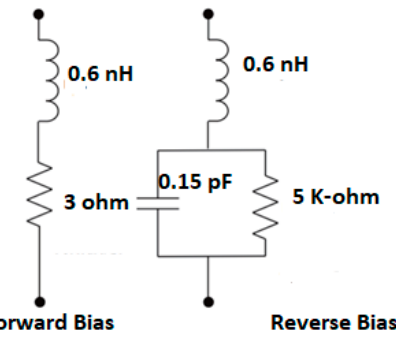
Figure 7. Equivalent circuit of p-i-n diode in ON–OFF condition. The antenna displays various frequency bands with the switching of the diodes. The simulated and measured outcomes provide good agreement, as presented in Figure 8. With both diodes in the ON condition, the antenna illustrates a resonance at 5.1 GHz, with an S 11 of − 24 dB from 2.7 to 5.9 GHz with a bandwidth of 3200 MHz, as shown in Figure 8a. Switching Diode-D1 OFF and Diode-D2 ON provides three bands, defined in Figure 8b, from 1.4 to 1.5 GHz, 2.7 to 4.2 GHz, and 4.6 to 5.9 GHz. With Diode-D1 turned ON and Diode-D2 turned OFF, there are three bands from 1.4 to 1.5 GHz, 2.7 to 4.4 GHz and 4.6 to 5.8 GHz, as depicted in Figure 8c. With both diodes in the OFF situation, as shown in Figure 8d, it shows three frequency bands from 2.3 to 3 GHz, 4.1 to 5.8 GHz, and 7.8 to 8.3